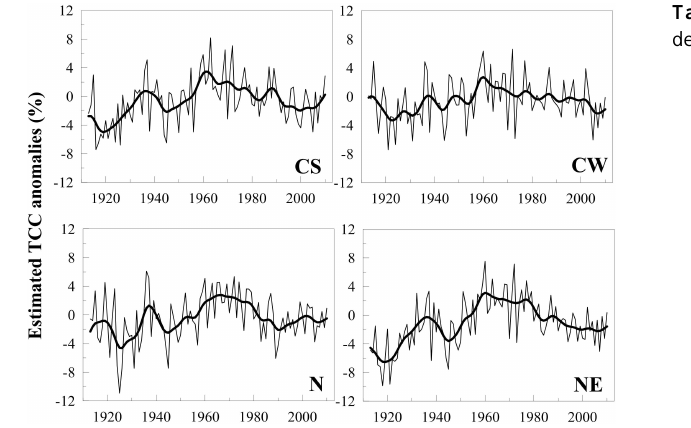
Fig. 6. As in Fig. 5, but for the annual mean estimated TCC (%) series of the four regions defined by means of a PCA applied to the 39 estimated TCC series. The series are only plotted for the subperiod 1913–2010 when all series are available.